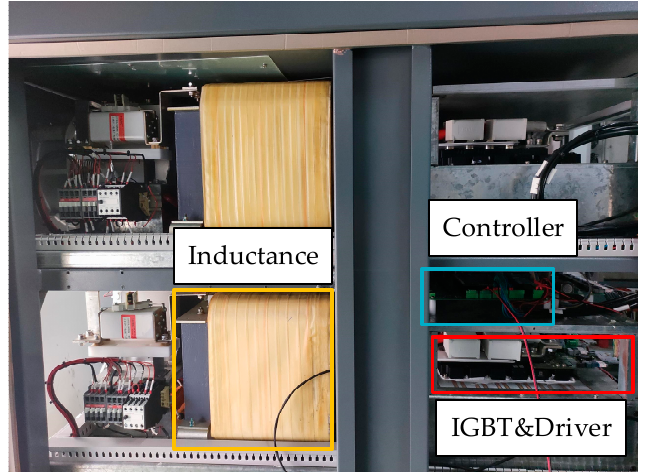
Figure 15. Experiment platform.